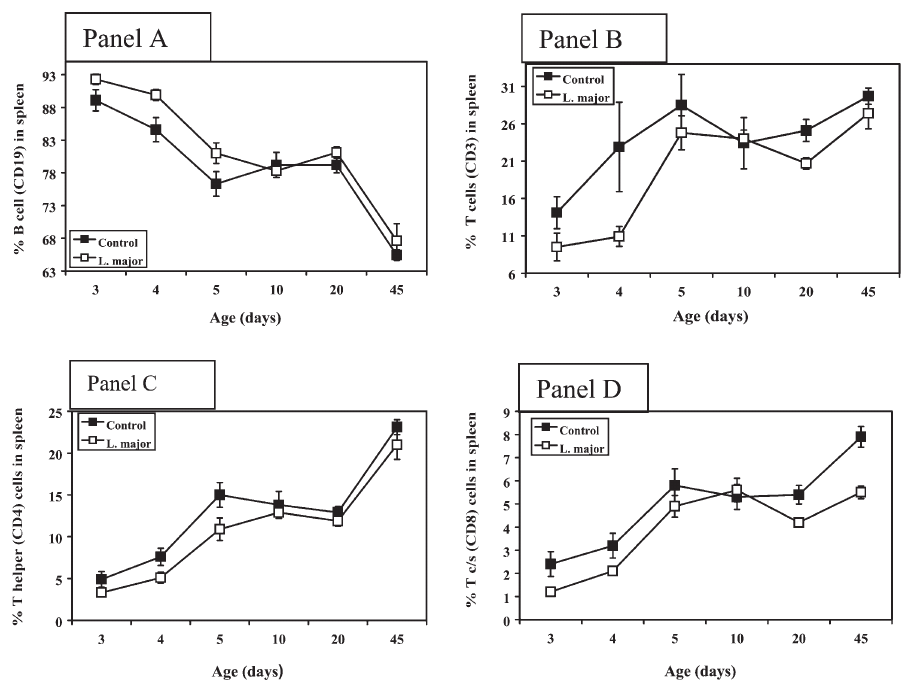
FIGURE 2 Main treatment effects were observed across all ages (two-way ANOVA, main effects, control vs. treatment group, p , 0 : 05 ) for proportions of B (CD19, Panel A), T (CD3, Panel B), Th (CD3CD4, Panel C) and Tc/s (CD3CD8, Panel D) in spleen of pups of various ages. Progeny was delivered from dams treated during gestation with saline or L. major (175 m g/mouse i.p in saline). Data points are mean ^ SE of 5 samples/age. Samples represent pools of randomized pups (d3–10, 5–14/pool; d20, 2/pool; d45, 1 pup). Statistical significance ð p , 0 : 05 Þ for treatment effects among groups was derived from two-way ANOVA. These analyses generated F statistics of 9.8 (CD19), 7.7 (CD3), 10.3 (CD4) and 16.4 (CD8) with 1 degree of freedom. No significant group interaction was observed for all. Post hoc analyses with Student’s t -test revealed differences among groups per age: d4 (CD19), d20 (CD3 and CD8). See “Statistical analysis” section for further details. At some ages, symbol area encompasses SE